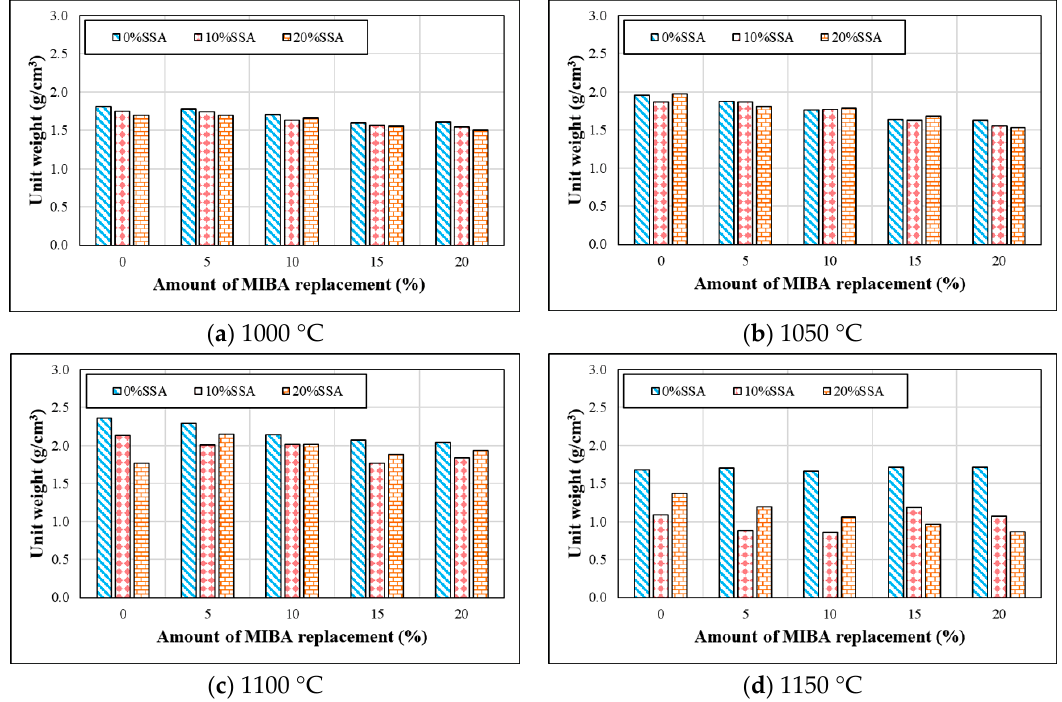
Figure 6. Specific gravity of specimens at different sintering temperature. ( a ) 1000 °C; ( b ) 1050 °C; ( c ) 1100 °C; ( d ) 1150 °C.